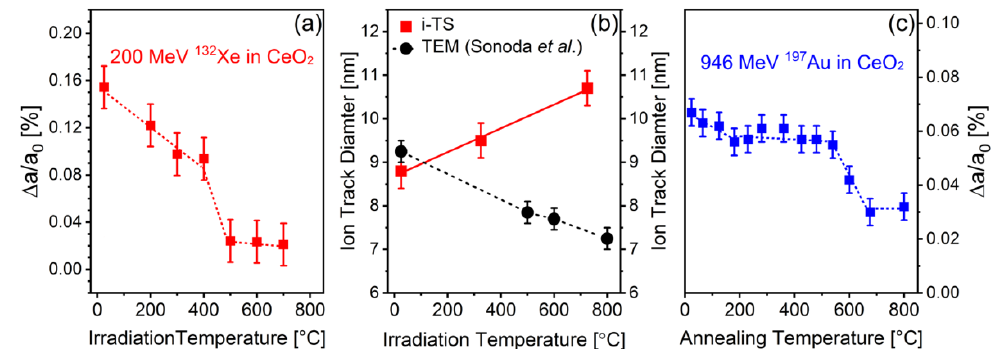
Figure 7. ( a ) Change in unit cell parameter from XRD pattern analysis as a function of irradiation temperature for CeO 2 irradiated with 200 MeV 132 Xe ions, relative to unirradiated reference samples heated under identical conditions [55]. ( b ) Ion track diameters determined by inelastic thermal-spike calculations [55] (red) and measured based on TEM images [32,33] ( black ) as a function of irradia- tion temperature. ( c ) Effect of thermal annealing on the relative change in unit cell parameter in CeO 2 previously irradiated with 946 MeV 197 Au ions [46]. Dashed and solid lines are to guide the eye. This figure was adapted from ( a , b ) Cureton et al. [55], ( b ) Sonoda et al. [32,33], and ( c ) Palo- mares et al. [46].